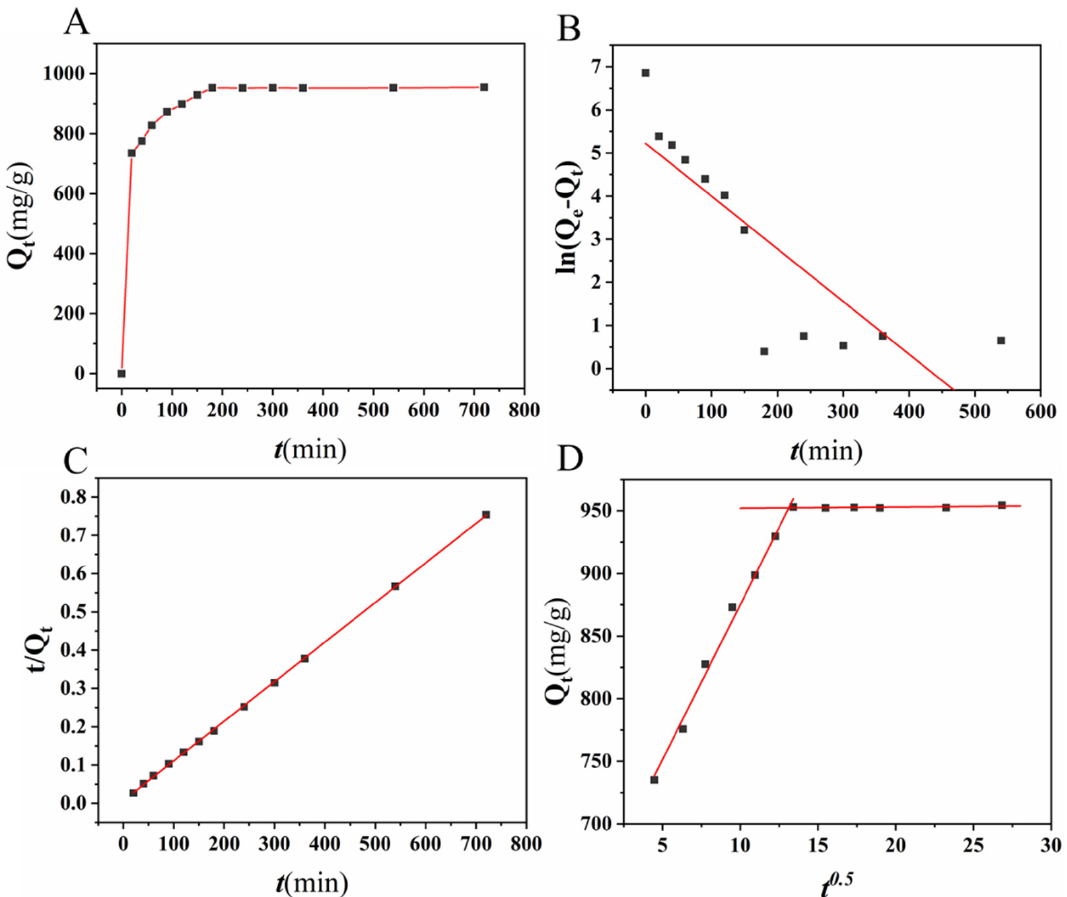
Figure 5. Adsorption kinetics of N-doped CM-chitin toward CR ( A ), Pseudo-first-order kinetic model ( B ), Pseudo-second-order kinetic model ( C ), and Weber-Morris kinetic model ( D ). For investigation the effect of temperature on the adsorption of CR on N-doped CM- chitin, the adsorption experiments were carried out at 290, 300, and 310 K. The energy of activations ( ∆ H) and enthalpy change ( ∆ S) was calculated from the Van ‘t Hoff equation (Equation (S12) and Figure S4), the Gibbs free energy change ( ∆ G) was measured from Equation (S13), and the thermodynamic results were listed in Table S3. From the results, ∆ H > 0 and negative ∆ G, indicating that the adsorption process is endothermic nature and spontaneous. ∆ S > 0 showed an entropy increase irregularities at the solid-liquid interface on the carbon nanofibers surface of N-doped